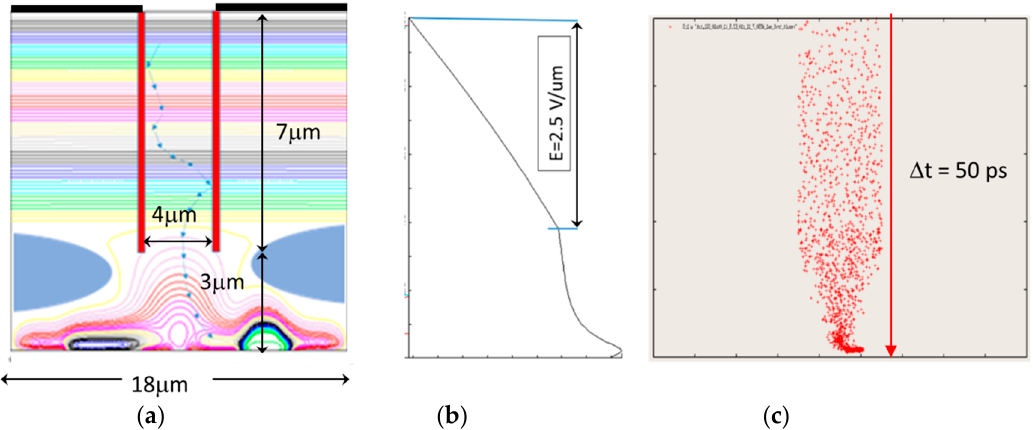
Figure 9. Simulation results of the design method of an ultra-high-speed image sensor based on the theoretical analysis of the temporal resolution limit.